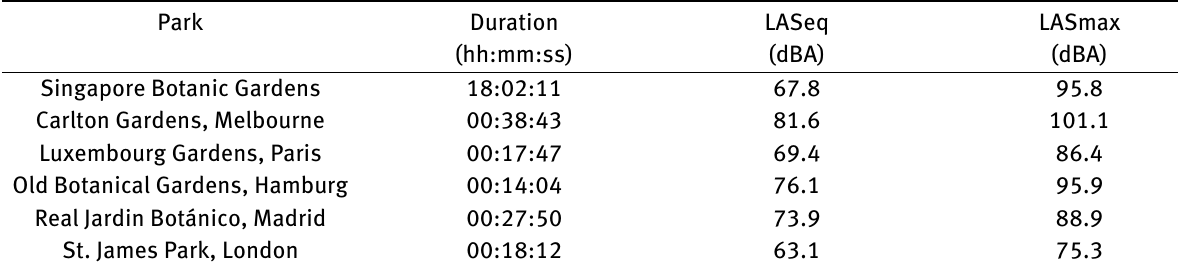
Figure 9: Two mini waterfalls next to the entrance of Orchid Gardens and their average frequency spectrums in dBA Table 2: The sound pressure levels in dBA of various gardens of the world